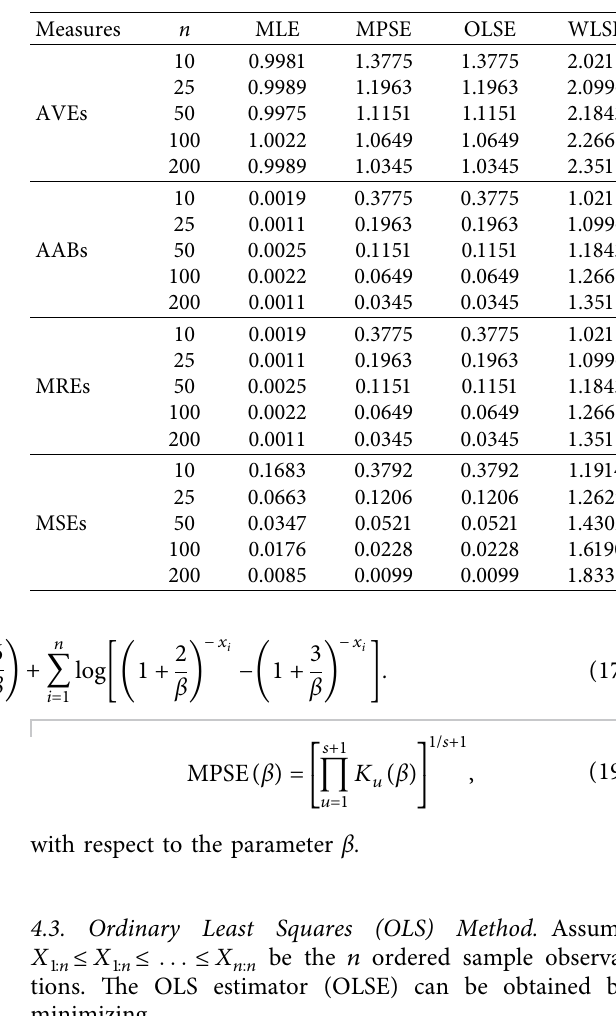
Table 3: Simulation results for β � 0 . 5. Table 4: Simulation results for β � 1 .